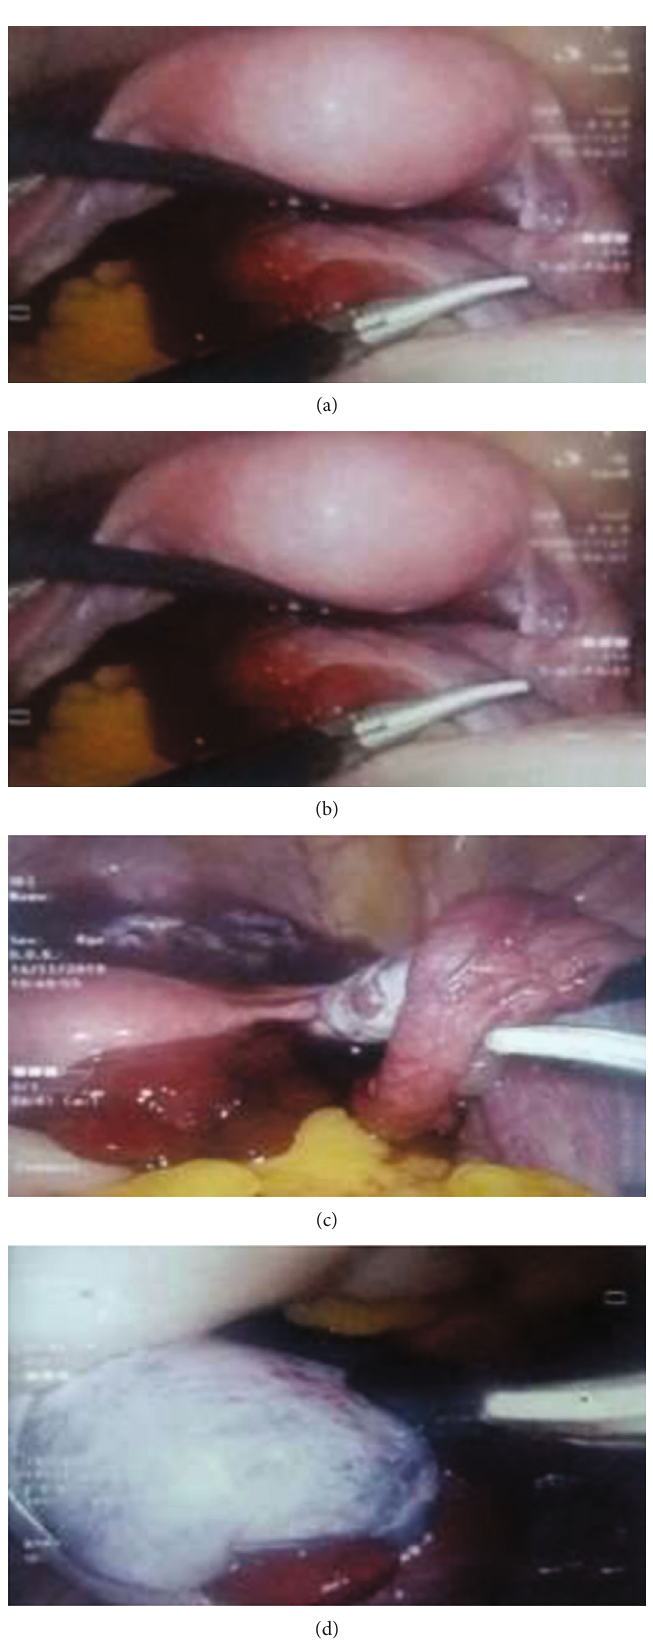
Figure 1: Sequential changes in the ovarian and tubal tissues in the teenager related to the case